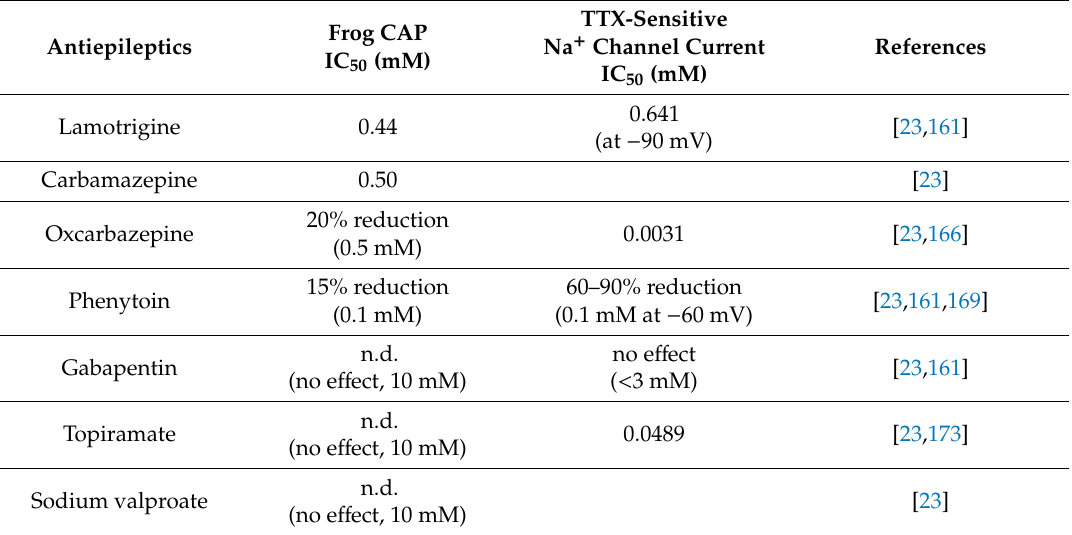
Table 4. Comparison of IC 50 values in inhibiting frog sciatic nerve fast-conducting CAPs and TTX-sensitive Na + channels among